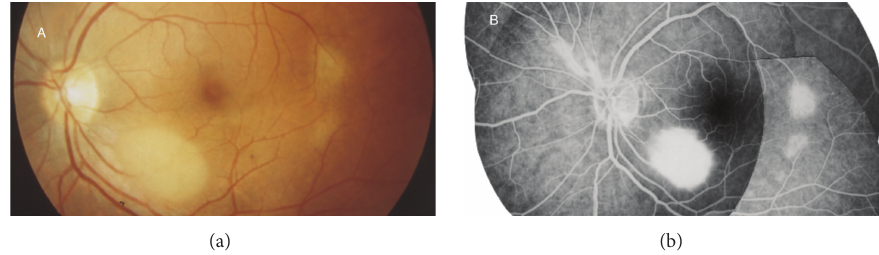
Figure 10: Astrocytic hamartoma of the retina in a patient with tuberous sclerosis complex. “Younger tuberous bodies” seen as smooth, flat translucent, or blurry lesions and “transitional tuberous bodies” seen as smooth, relatively flat, noncalcified, grey/white lesions with an oval or circular shape. (a) Fundus photograph and (b) corresponding fluorescein angiography image (from [6]).